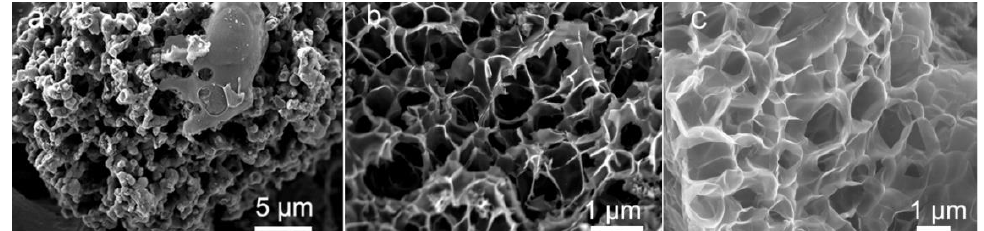
Figure 5. SEM images of synthesized honeycomb-like carbon materials using different amounts of PA: ( a ) 0 mL, ( b ) 1 mL, and ( c ) 5 mL. Reproduced with permission from [65]. Copyright 2021 Elsevier